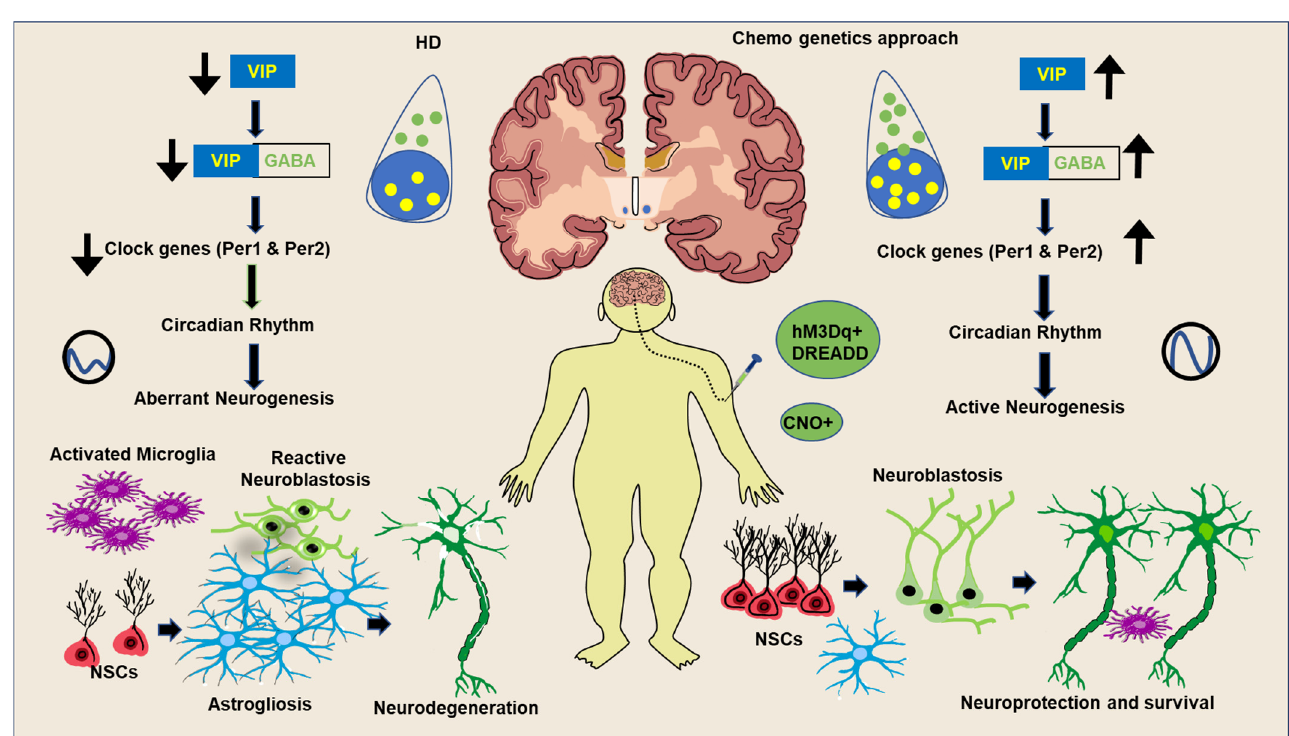
Figure 5. Possible therapeutic implication of chemogenetics in HD.